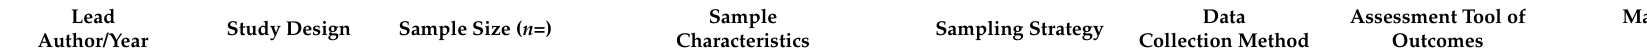
Table 1. Major characteristics of studies on the mental health impacts of COVID-19 on Chinese older